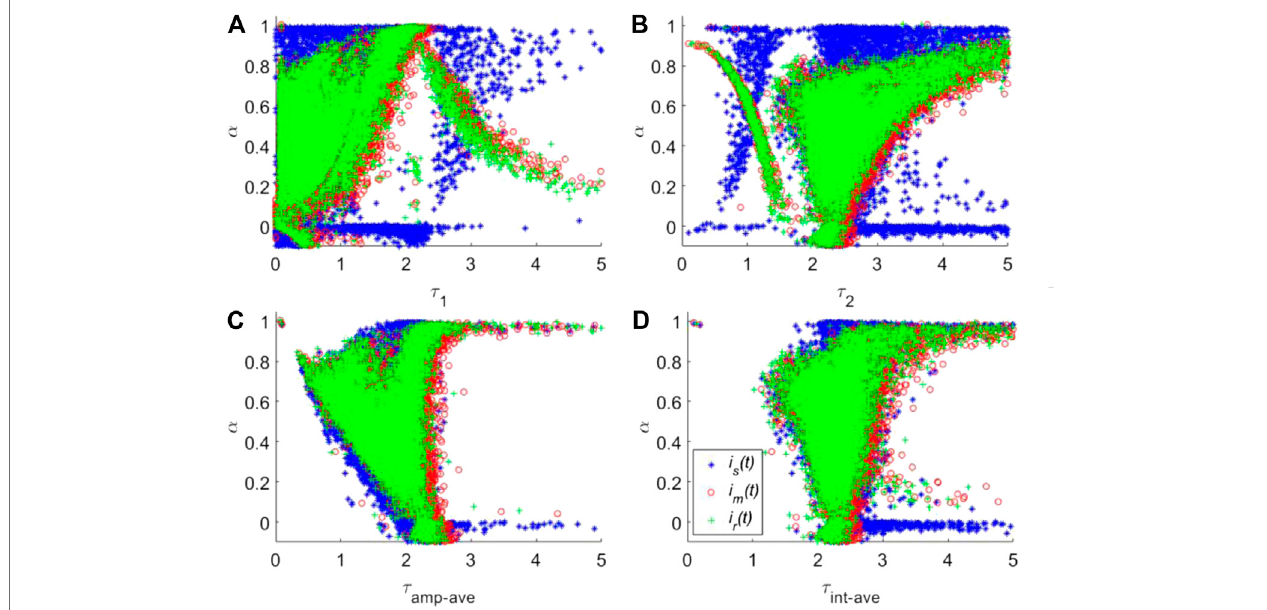
FIGURE 7 | Calculated τ 1 (A) , τ 2 (B) , τ amp-ave (C) and τ int-ave (D) vs. α using three different IRFs, i s (t) , i m (t) and i r (t) .